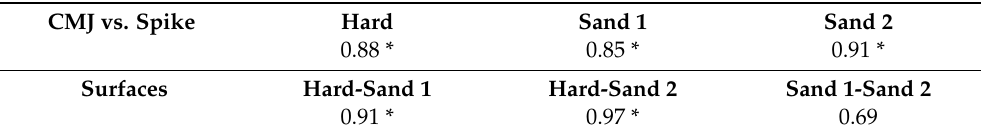
Table 3. Spearman’s correlation coefficients of VM/VL ratios for jump tasks and surfaces. Correlations of VM/VL ratios between CMJs and spike jumps on the three various surfaces are displayed in the upper row. Correlations of VM/VL ratios in spike jumps between the three surfaces are displayed in the lower row. * indicates significant correlation with p < 0.01. CMJ vs.